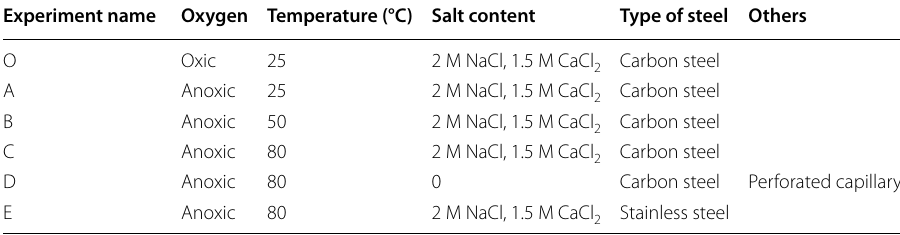
Table 1 Composition and conditions of experimental solutions in the reservoir container. All solutions contain initially 1 mM